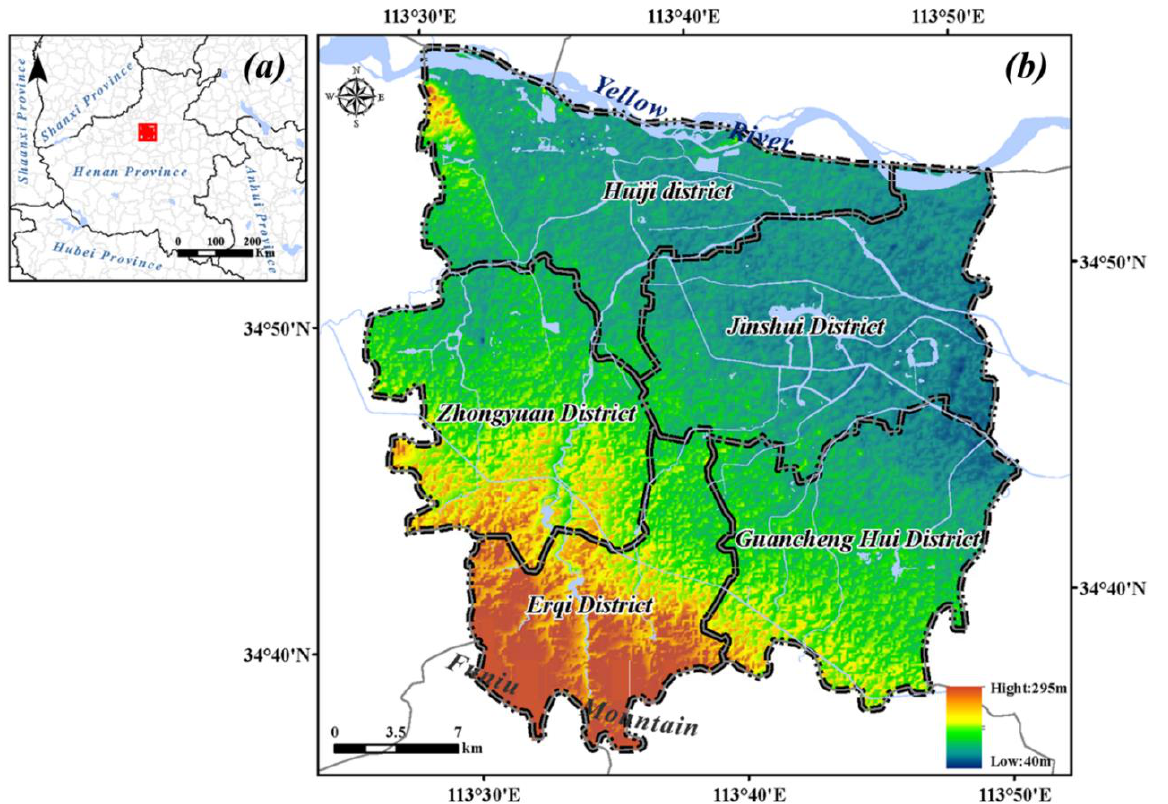
Figure 1. ( a ) Location of research area. ( b ) Elevation of research area. (Data source: National Geomatics Center of China http://www.ngcc.cn/ngcc/, accessed on 10 November 2021). It consists of five administrative districts: Jinshui District, Erqi District, Guanchenghuizi District, Zhongyuan District, Huiji District. The built-up area is 1181.51 square kilometers (Figure 1) [22]. According to the seventh national census of the People’s Republic of China in 2020, the resident population of Zhengzhou is 12.6